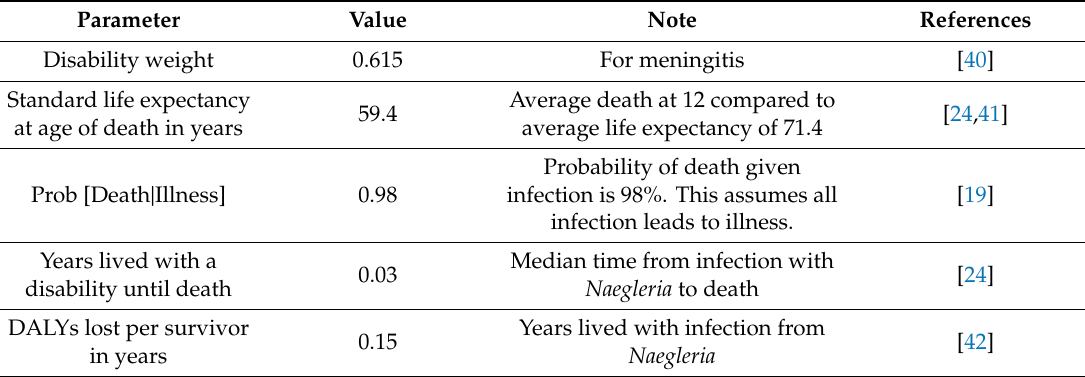
Table 2. Disability-adjusted life years (DALYs) input parameters for Naegleria